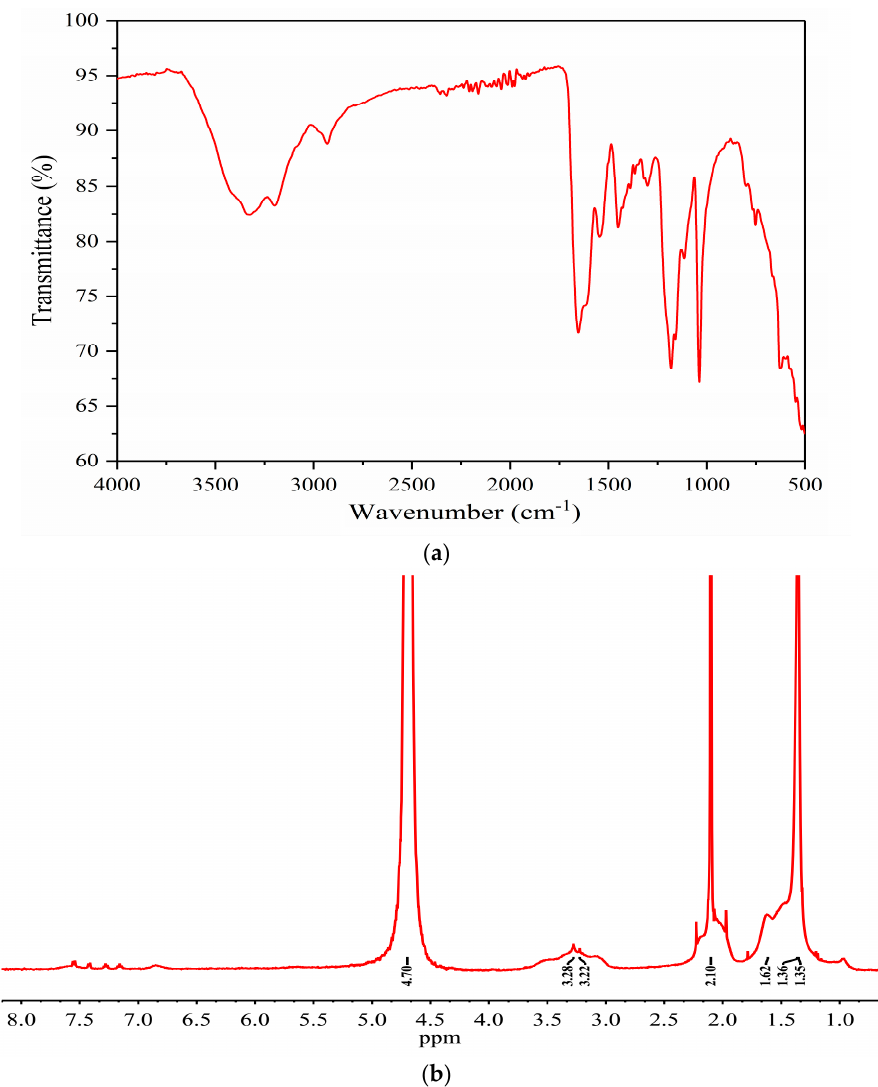
Figure 3. FTIR ( a ) and NMR ( b ) spectra of THERMOASSOCIATIF copolymer.